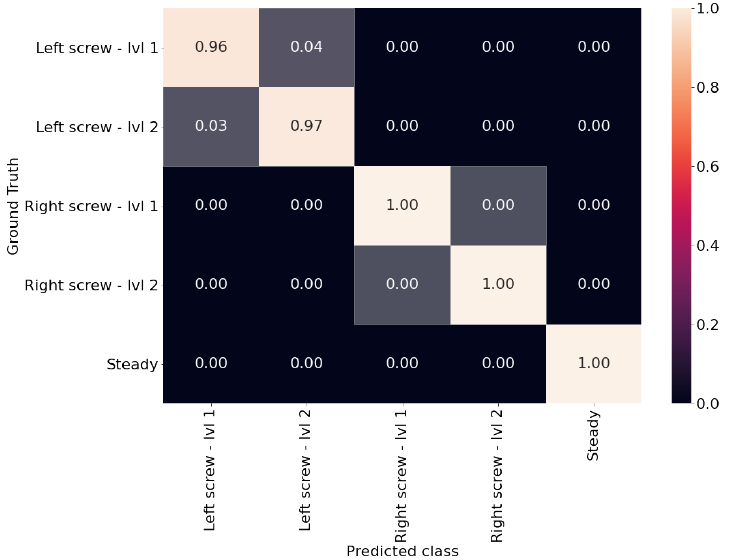
Figure 11. Confusion matrix for the Industrial